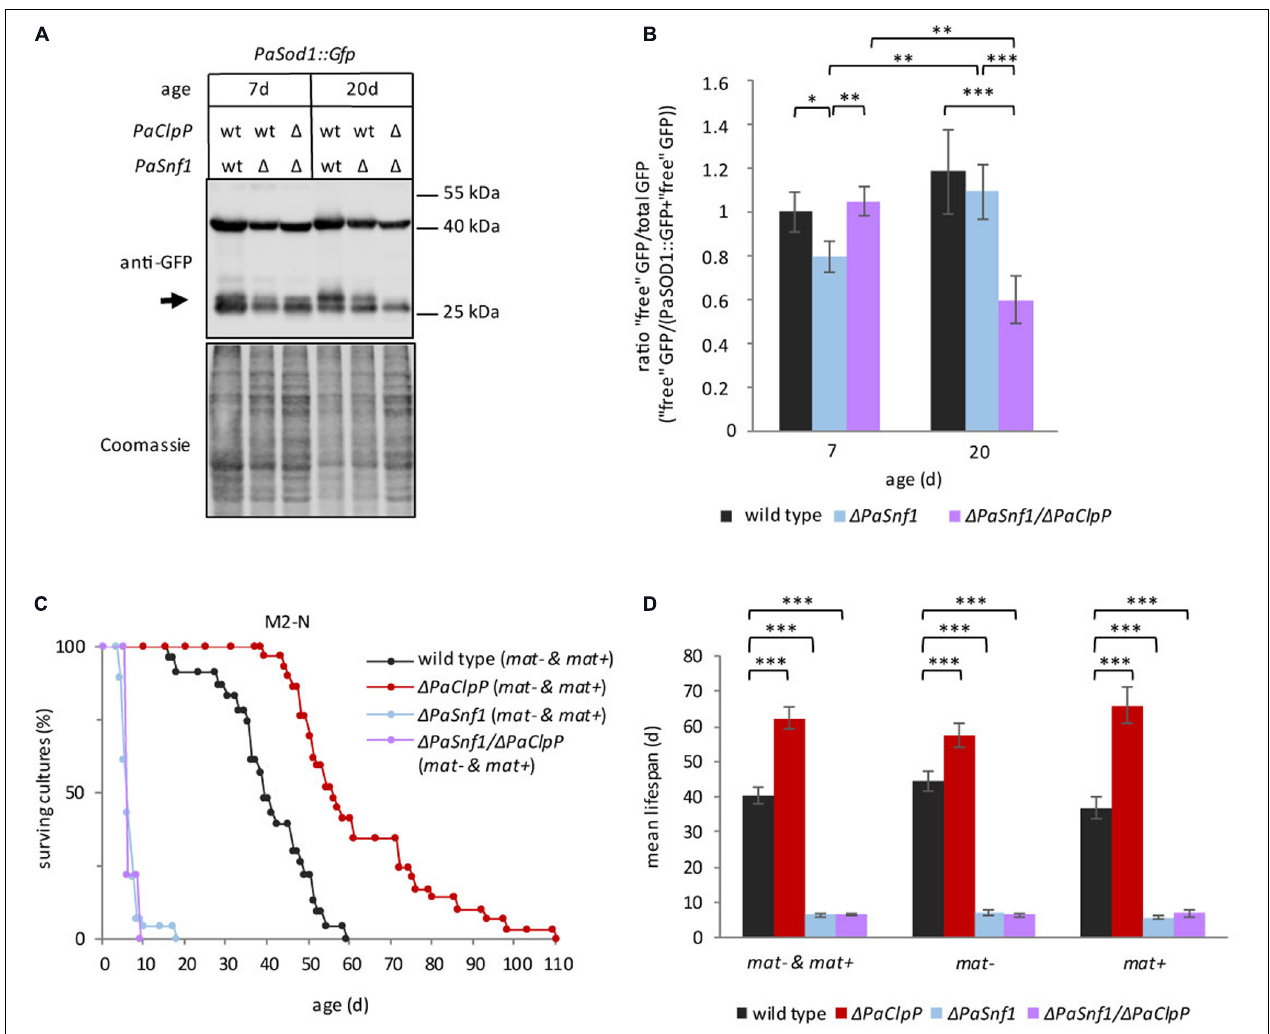
FIGURE 4 | Deletion of PaSnf1 leads to impaired autophagy. (A) Western blot analysis of (cid:49) PaSnf1 and wild type expressing the autophagy marker gene PaSod1::Gfp of 7- ( PaSod1::Gfp n = 5; (cid:49) PaSnf1 / PaSod1::Gfp n = 4; (cid:49) PaSnf1 / (cid:49) PaClpP / PaSod1::Gfp n = 3) and 20-day-old ( PaSod1::Gfp n = 5; (cid:49) PaSnf1 / PaSod1::Gfp n = 5; (cid:49) PaSnf1 / (cid:49) PaClpP / PaSod1::Gfp n = 4) strains. 50 µ g of total protein extract was separated in a 12% SDS polyacrylamide gel. After transfer on a PVDF membrane, the gel was stained with Coomassie and serves as loading control. The signal of “free GFP” is marked with an arrow. (B) Quantification of the relative amount of “free GFP”/total GFP. The values shown are mean ± SD. (C) Lifespan analysis of (cid:49) PaSnf1 ( n = 28, p < 0.001), (cid:49) PaClpP ( n = 29, p < 0.001), (cid:49) PaSnf1 / (cid:49) PaClpP ( n = 9, p < 0.001), and wild type ( n = 23), grown on M2 medium without nitrogen and with 1.5-fold glucose at 27 ◦ C (constant light). P -values of the lifespan curves in comparison to wild type were determined by SPSS with three different statistic tests. All p -values are provided in Supplementary Tables 2, 3 . (D) Mean lifespan of cultures from (C) ± SEM. “ mat– & mat+ ” represents the mean lifespan taking together both mating types; “ mat– “ shows the mean lifespan of cultures with mating type ”minus“ ( rmp1-1 ). ” mat+ “ shows the mean lifespan of cultures with mating type ”plus“ ( rmp1-2 ). ( ∗∗∗ : p < 0.001; **: p < 0.01; *: p < 0.05, two-tailed Student’s t